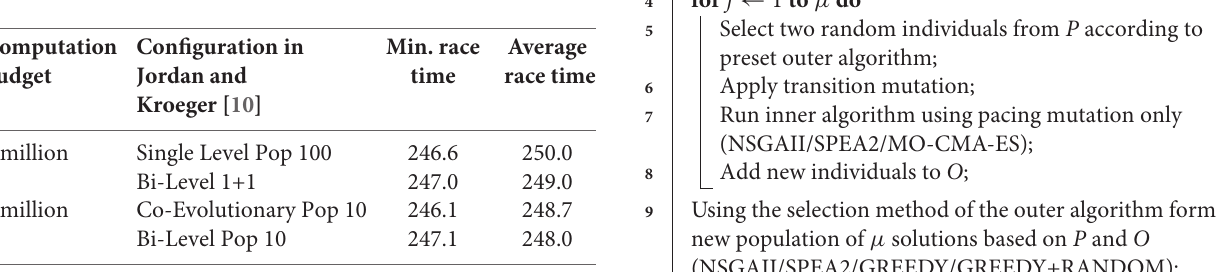
Algorithm 2 outlines our framework for the race